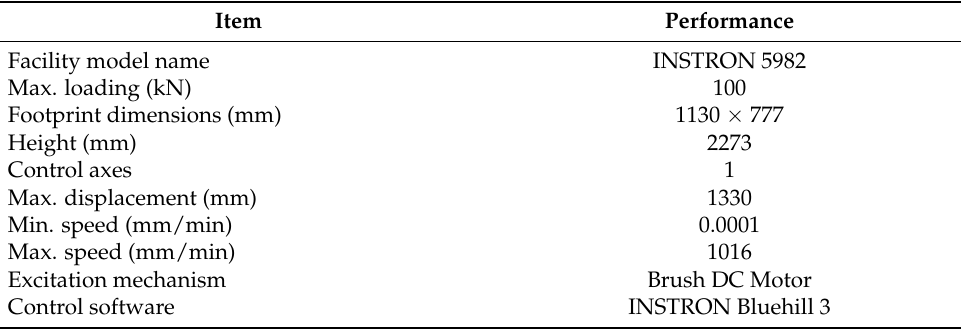
Figure 16. Photos of steel damper specimen and test facility: ( a ) Steel damper specimen; ( b ) test facility with specimen. Table 12. Performance characteristics of test facility.